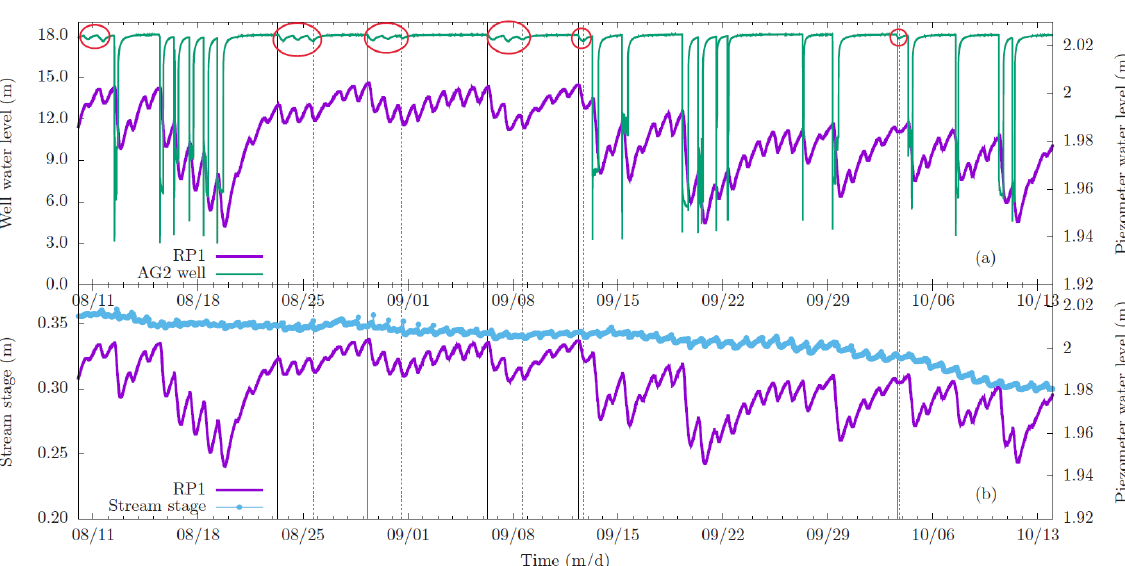
Figure 11. Close-up view of water levels in ( a ) well AG2 and piezometer RP1, and ( b ) the stream stage and piezometer RP1 over the period August–October 2016. The large drawdown responses ( ≥ 15 m) in the top graph are those of well AG2 water levels to pumping in AG2, and the ones circled in red are the responses of well AG2 water levels to pumping periods in AG3. The vertical solid (start) and dashed (end) lines mark the AG3 pumping period. The small drawdown responses ( ≥ 0.05 m) in the graphs are those of piezometer RP1 water levels to pumping in wells AG2 and AG3 and groundwater uptake by phreatophytic riparian